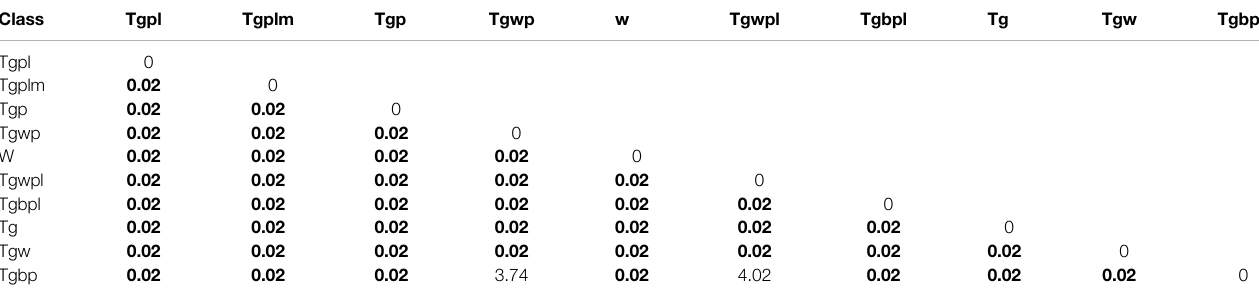
TABLE 2 | p -values with Bonferroni correction from pairwise permutational t-tests (n (cid:1) 999) of ST values for the top ten STURLA classes. Class